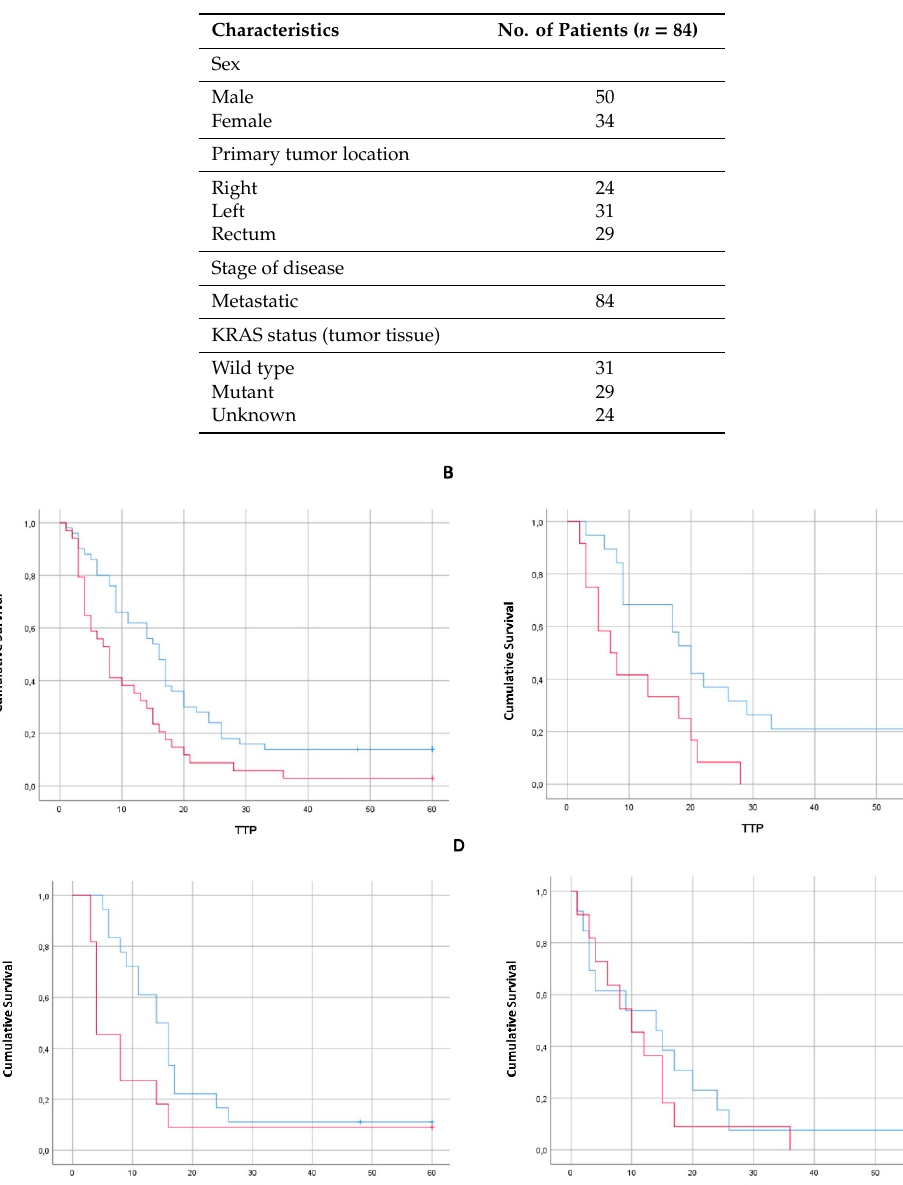
Table 1. Demographic and clinicopathological characteristics of patients analyzed for circulating tumor cells (CTC) enumeration (CellSearch ® ).